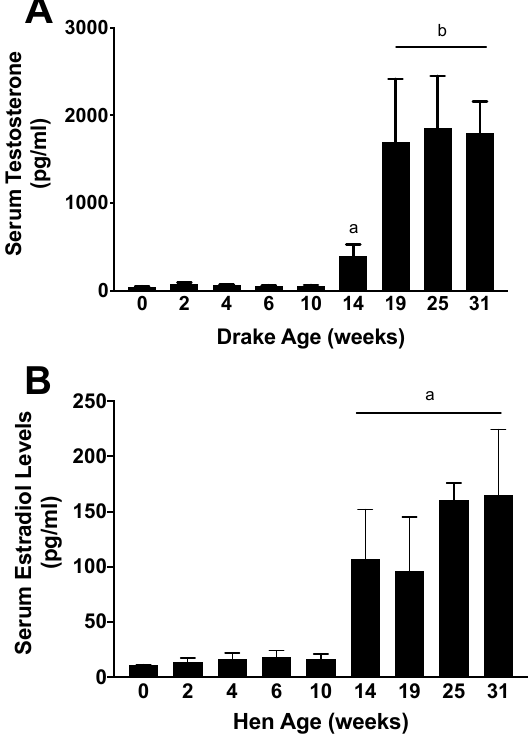
Figure 2. Serum T and E 2 concentrations in drakes and hens, respectively. ( A ) Serum T concentrations in drakes are at minimal concentrations from hatch through 10 weeks of age. T concentrations were significantly greater by 14 weeks of age, and again significantly increased 19 weeks and maintained into adulthood. Letters indicate statistically significant groups, a = p < 0.05, b = p < 0.01. ( B ) Serum E 2 concentrations were also at baseline from hatch through week 10 and were significantly increased to adult-like concentrations by week 19. a = p < 0.001. Data suggest that gonadal development is occurring by week 14 and may be more advanced in hens compared to drakes.